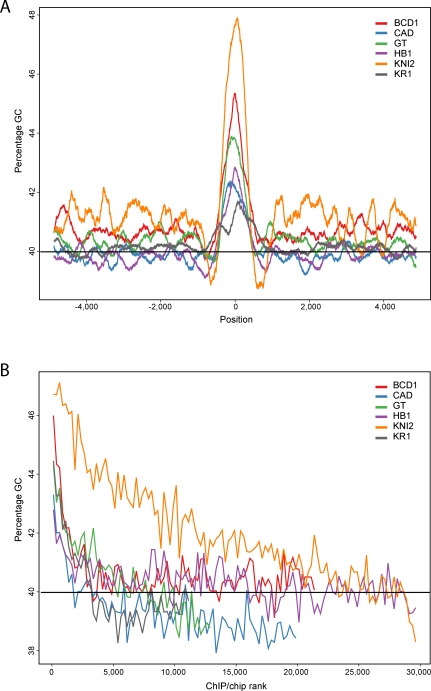
Bound Regions in Noncoding DNA Display a GC Bias(A) Average base composition (as represented by percentage GC) in nonoverlapping windows of 100 bp across the 10-kb regions (±5 kb) around 1% FDR primary peaks.(B) Base composition of the 500 bp (±250 bp) around primary peaks down the ChIP/chip rank list to the 80% FDR cutoff in nonoverlapping windows of 250 peaks. For both panels, only noncoding sequence was used in the analysis. The mean percentage GC content in noncoding DNA is indicated by the horizontal black line.